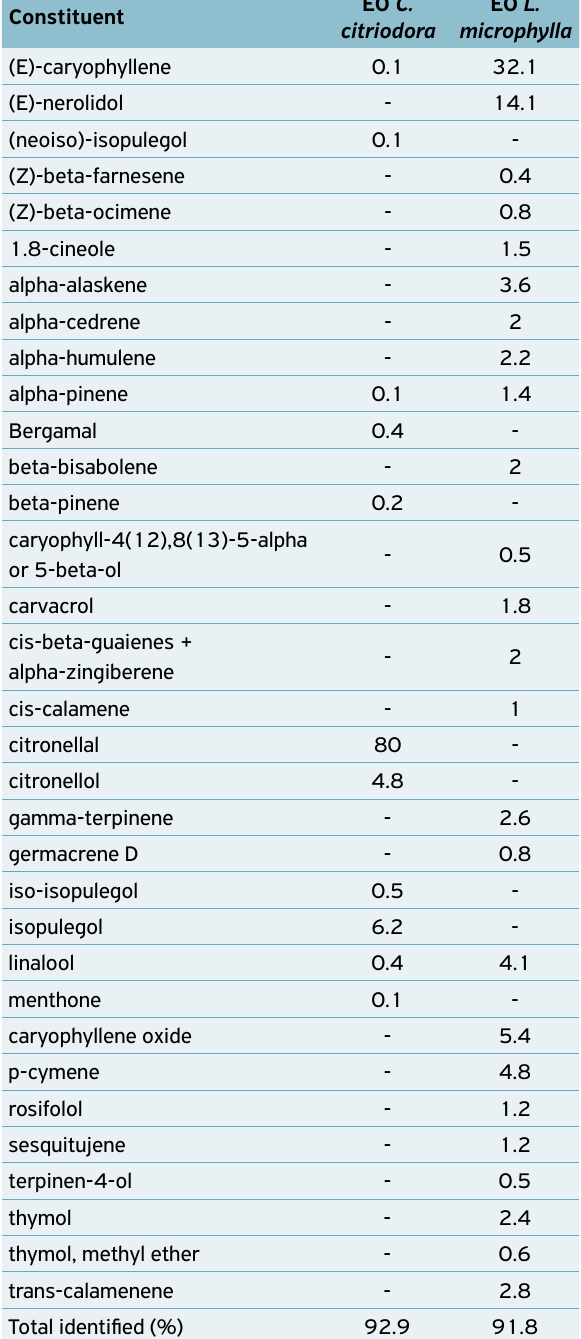
Table 2. Chemical composition (%) of essential oils of Corymbia citriodora and Lippia Microphylla